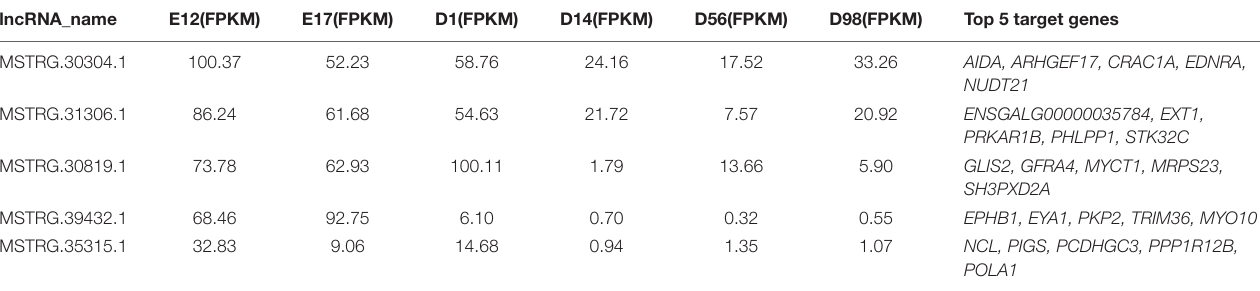
TABLE 1 | The top five differentially expressed lncRNAs and their target genes in profile 4.